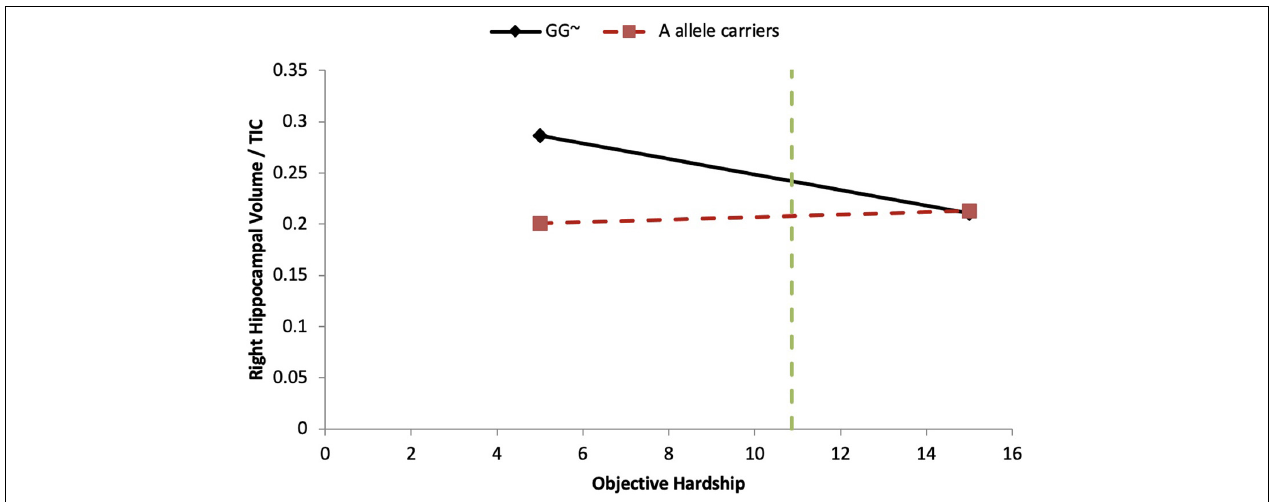
FIGURE 3 | COMT moderates objective hardship on right HCV/TIV ratio in boys. Moderation analyses demonstrate that there is a significant COMT-by-Objective PNMS interaction effect in boys ( p = 0.049). For the major homozygote (COMT genotype GG, solid line) there is a marginally significant negative association between objective hardship and right HCV/TIV ratio volume ( p = 0.084); however, for the heterozygote and minor homozygote COMT genotypes (A allele carriers, red dashed line) there is no association between objective hardship and right HCV/TIV ratio. There is a region of significance ( p < 0.05) when objective hardship levels are below 10.86, such that participants with major genotypes have a larger right HCV/TIV ratio compared to minor allele carriers. The green dashed line indicates the value of 10.83. ∼ p <